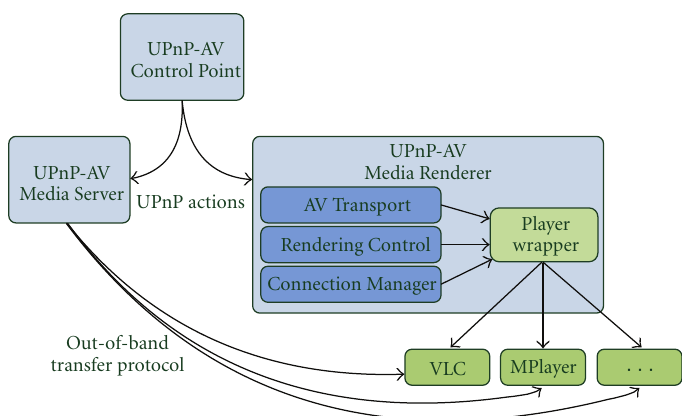
Figure 4: Conceptual view on the generic UPnP-AV Media Renderer